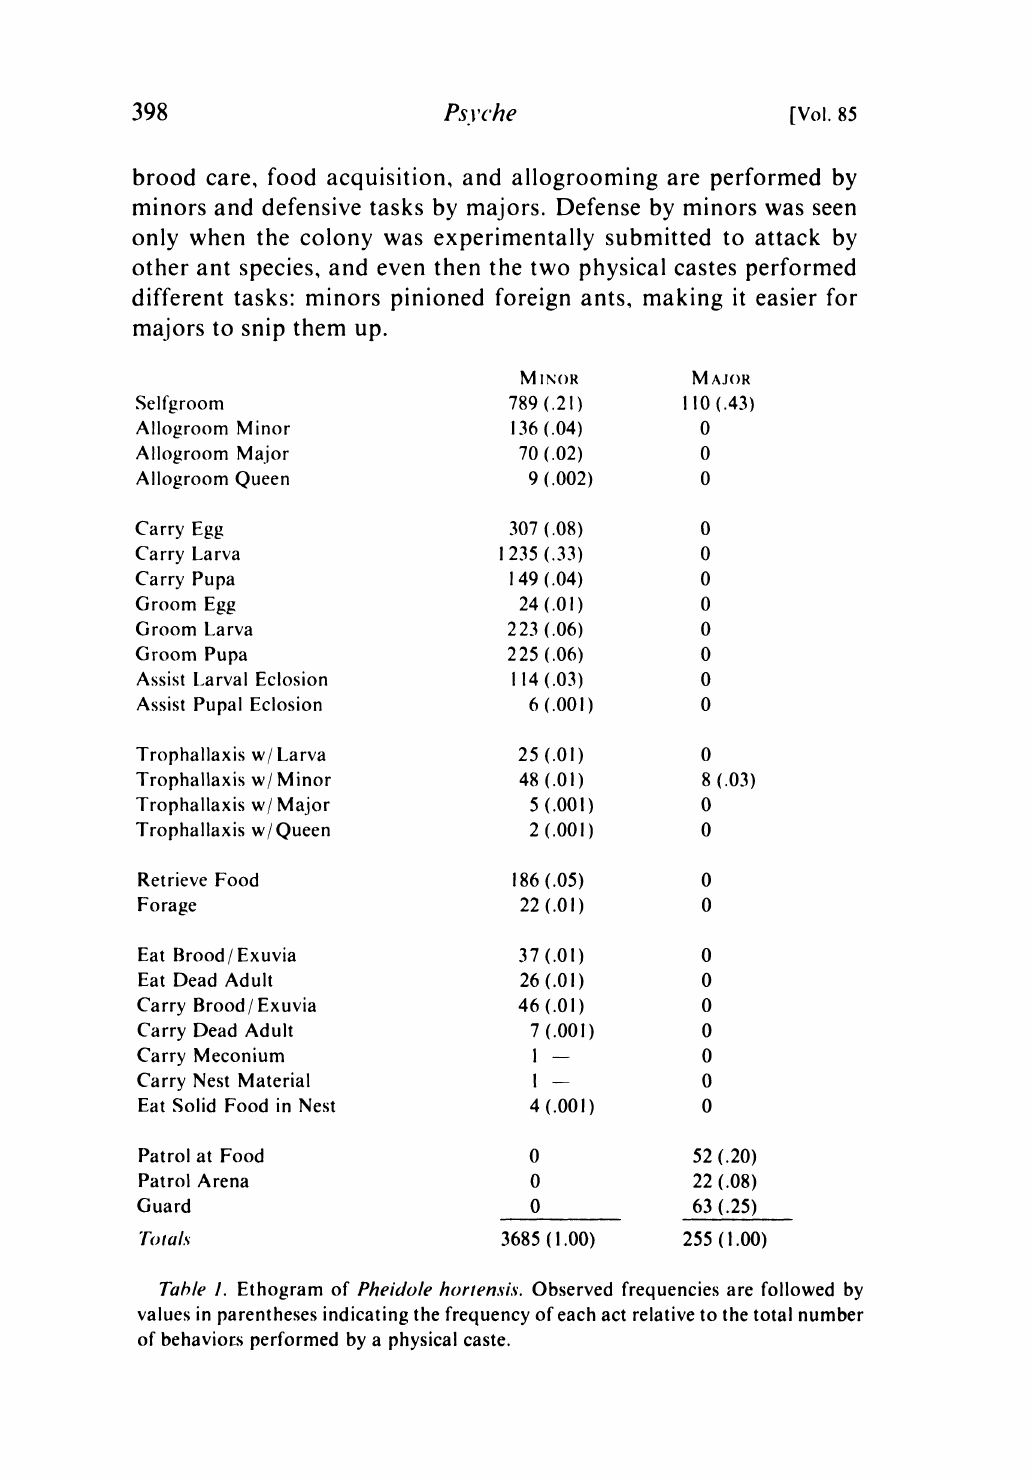
Table !. Ethogram of Pheidole hortensis. Observed frequencies are followed by values in parentheses indicating the frequency of each act relative to the total number of behaviors performed by a physical